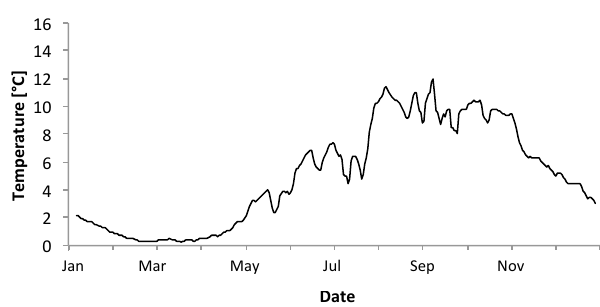
Figure 4. Five-day average temperatures through 2011 at Bay Bulls, Bread and Cheese Cove, at 10m, taken with HOBO data loggers.